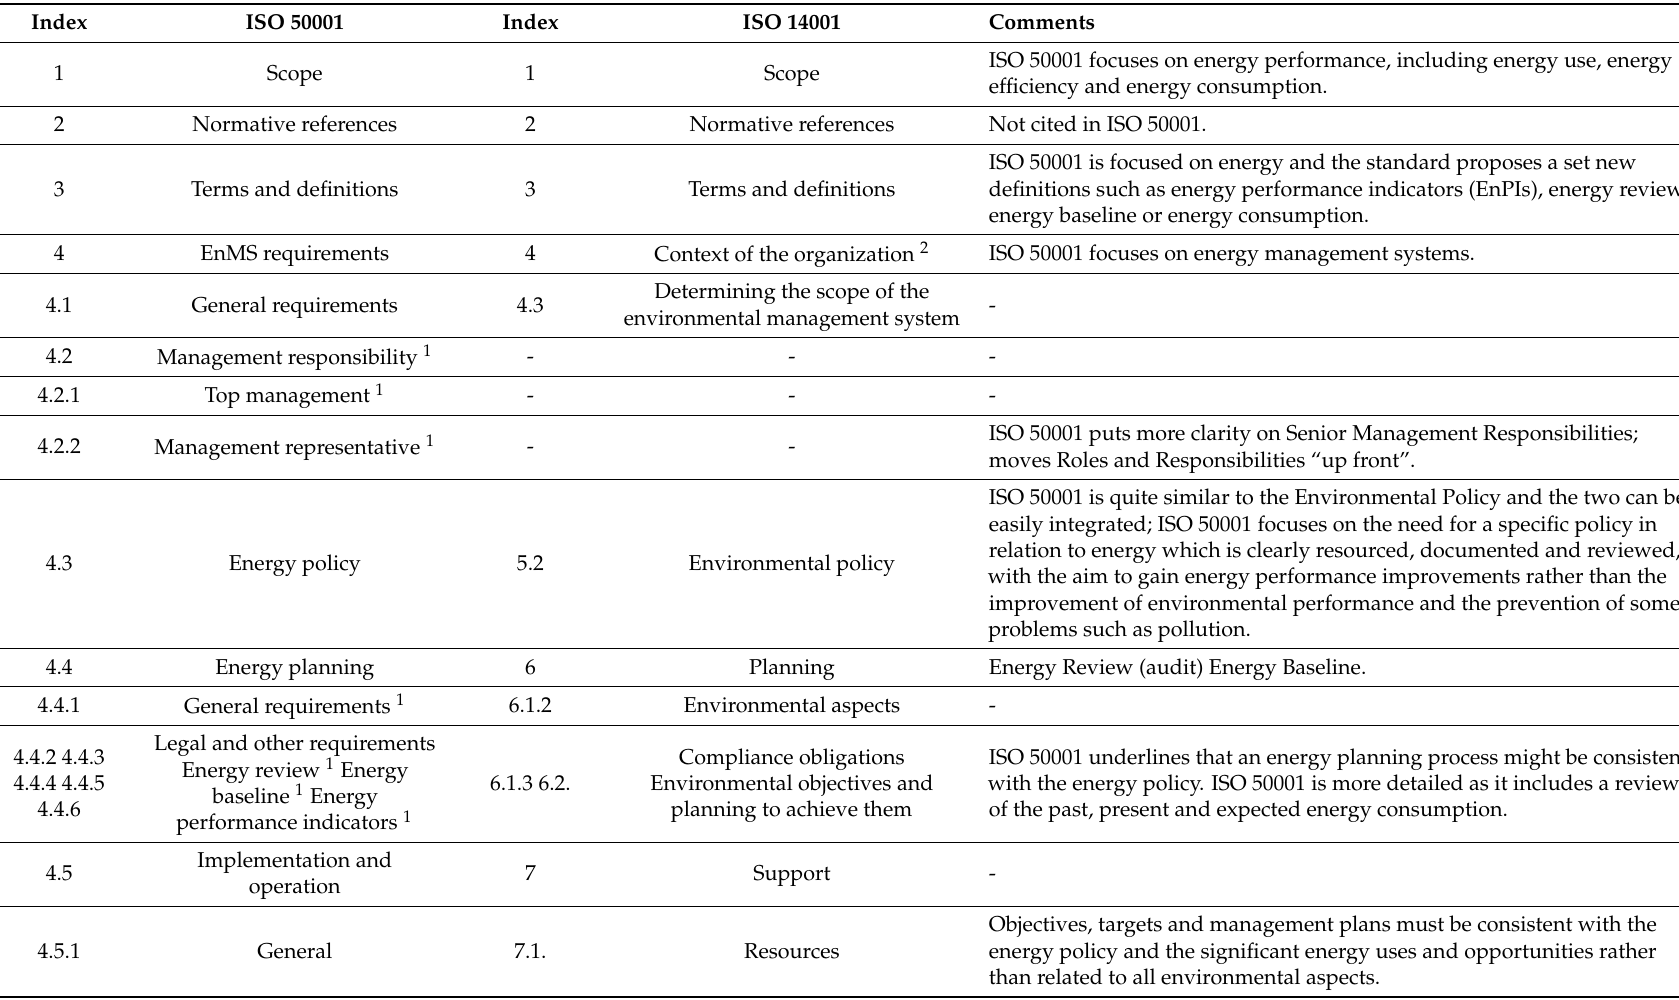
Table 1. Comparison of the ISO 50001:2011 and the ISO 14001:2015